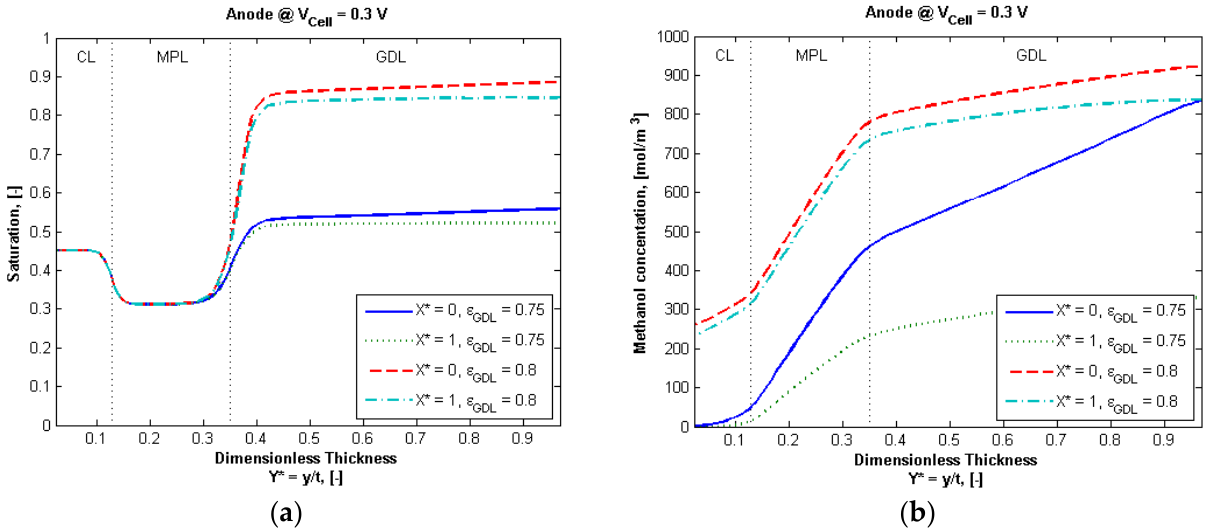
Figure 5. ( a ) Liquid saturation distribution in the anode electrode for two cases of GDL porosity at a cell voltage 0.3 V; ( b ) methanol concentration distribution in the anode electrode for two cases of GDL porosity at cell voltage 0.3 V. A dimensionless distance of X* = 0 and X* = 1 are equivalent to under the channel and land, respectively.